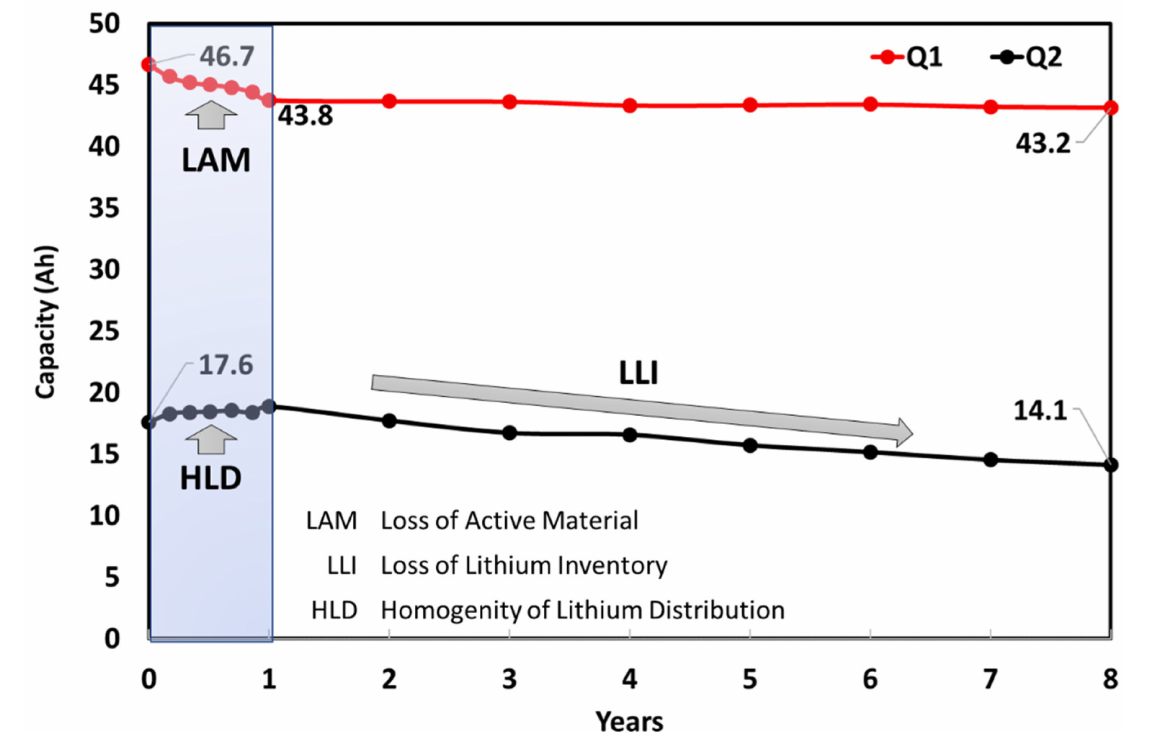
Figure 14. Evolution of Q1 and Q2 regions during the driving cycle ageing and ageing